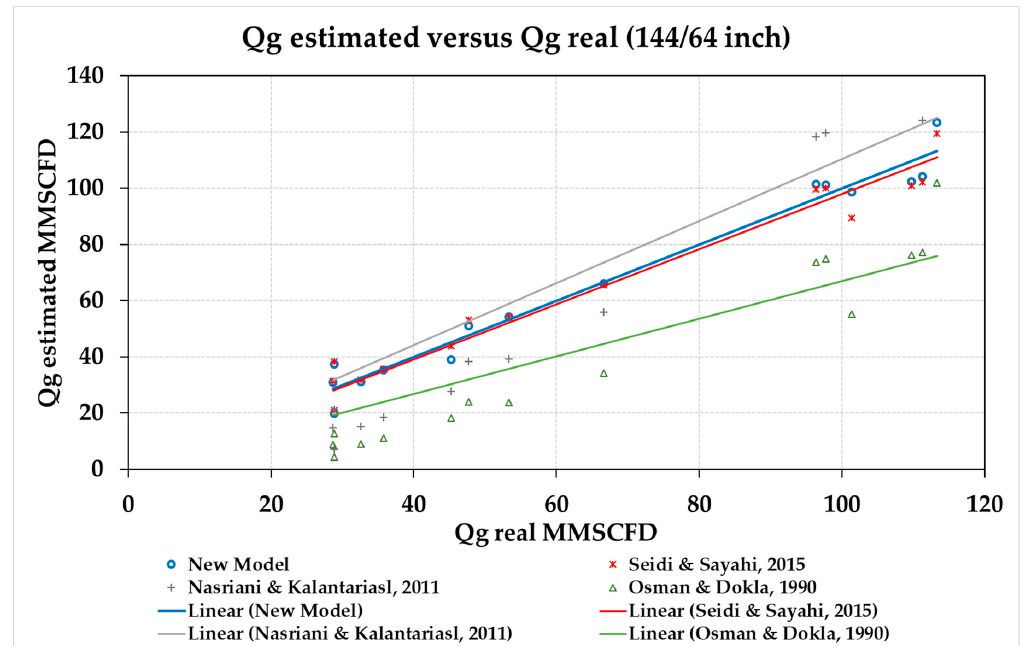
Figure 9 . Estimated gas flow rate versus real gas flow rate (144/64 inch) .